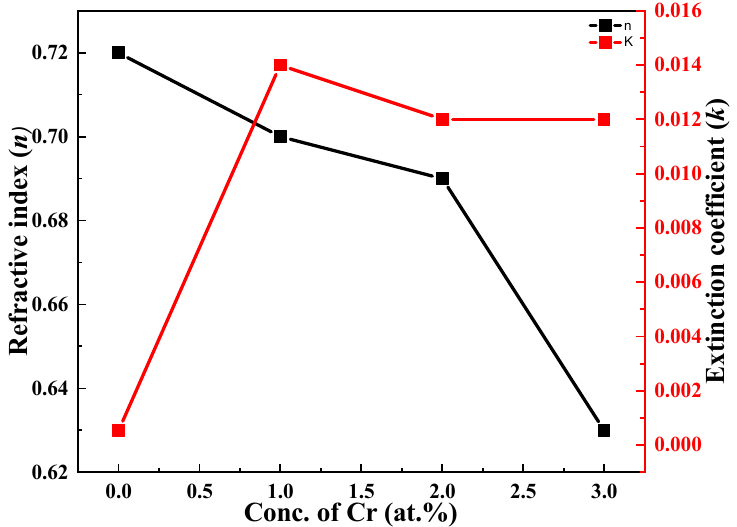
“ h ” stands for Planck’s constant (6.62 × 10 − 34 Js), “ υ ” stands for light frequency, A is the constant, and “ α ” stands for the absorption coefficient calculated from this relationship. Regarding the dependence of the composition of thin films on the band gap, a decrease in the band gap as shown in Figure 6 is credited to manifestation in the band structure by introducing discrete impurity levels [48]. Crystallinity, an important factor, might also speculate its role in the decrement in the band gap [49].